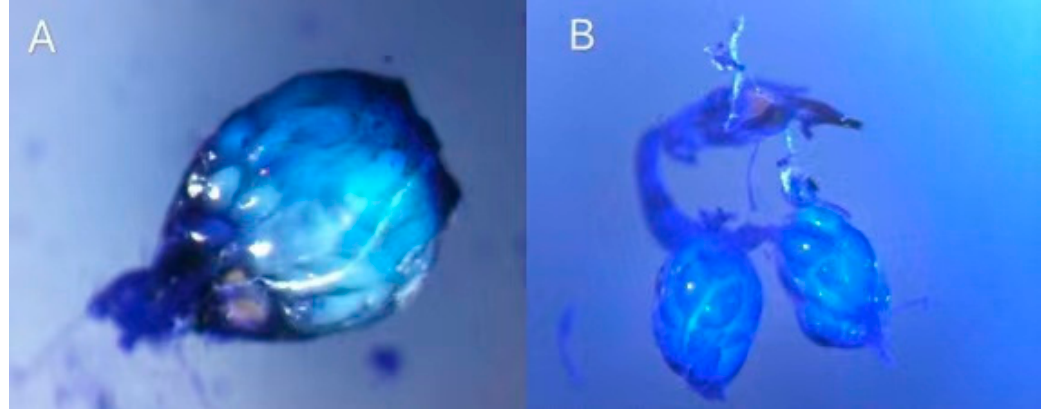
Figure 6. Trissolcus mitsukurii: full egg load in the abdomen (urotergum removed from abdomen) ( A ) and dissected reproductive organs showing ovaries, oviduct and ovipositor ( B ).